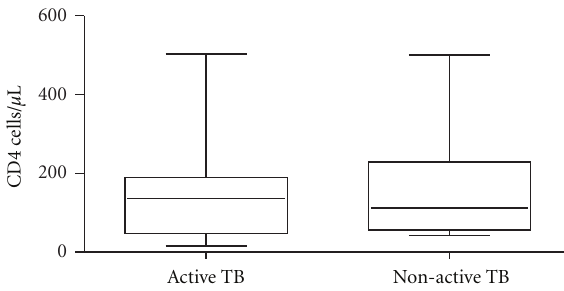
Figure 3: CD4 count in the active and non-active TB groups.